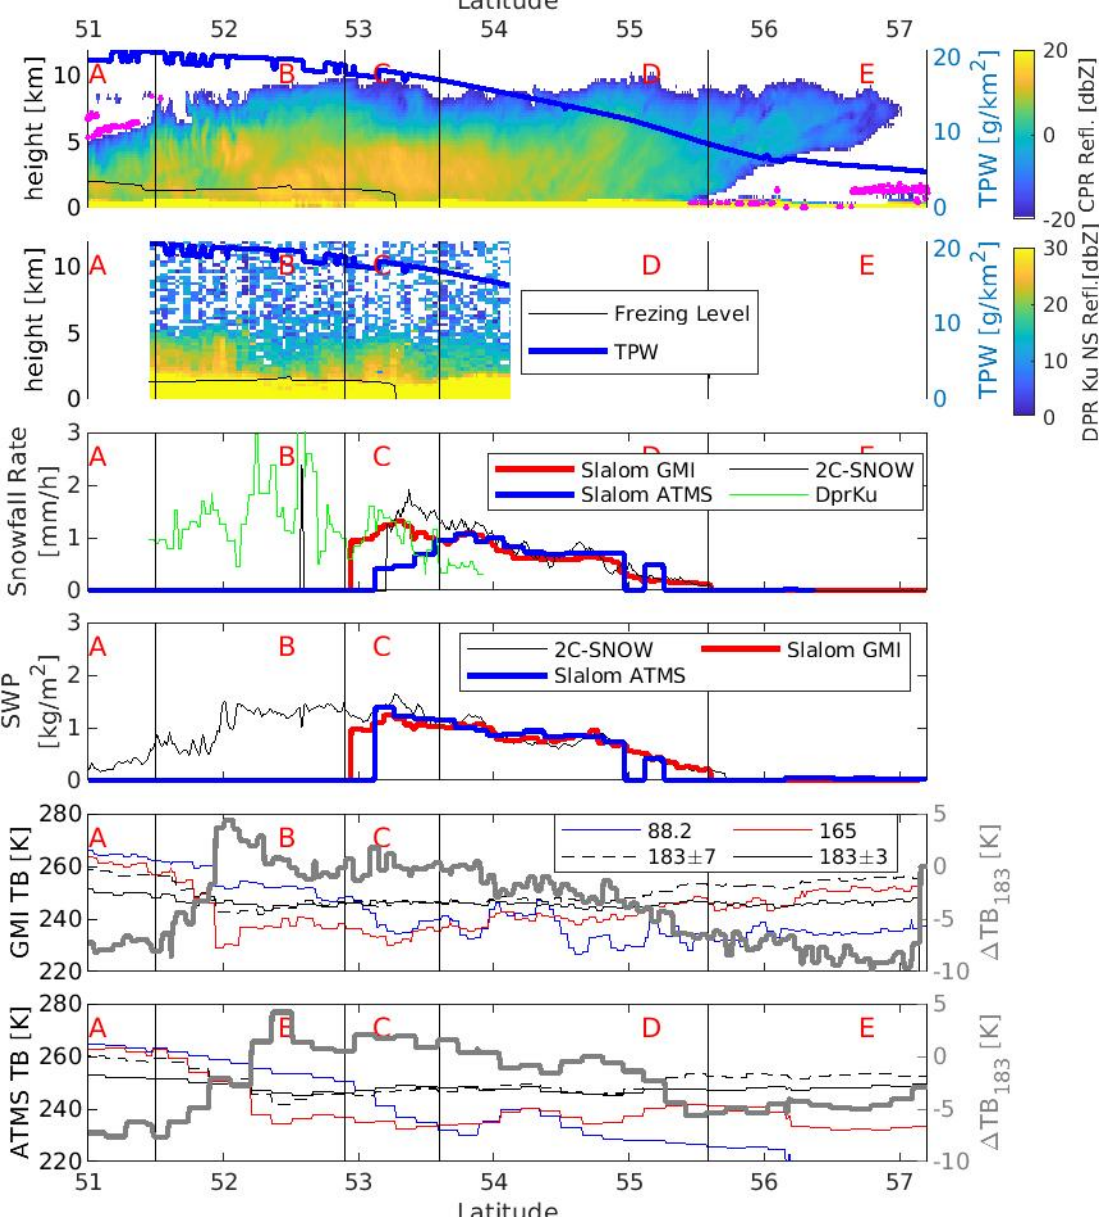
Figure 7. Analysis of a snowfall event over Quebec and Ontario regions in Canada on 24 November 2014 (CloudSat orbit 45,620 at 1802 UTC, GPM orbit 4202 at 1800 UTC, Suomi-NPP orbit 15,937 at 1811 UTC). From top to bottom: cross section of CPR (first panel) and DPR Ku-band (second panel) radar reflectivity with color bar in dBZ, alongside the total precipitable water vapor (TPW) (blue thick line, with values on the right-side y -axis) and freezing level (thin black line). Below these are the comparison of the surface snowfall rate from SLALOM applied to GMI and ATMS, the CPR 2C-SNOW-PROFILE, and the DPR Ku products (third panel), the snow water path (SWP) from SLALOM applied to GMI and ATMS and the CPR 2C-SNOW-PROFILE (fourth panel), and the GMI and ATMS brightness temperatures (fifth and sixth panels, respectively).